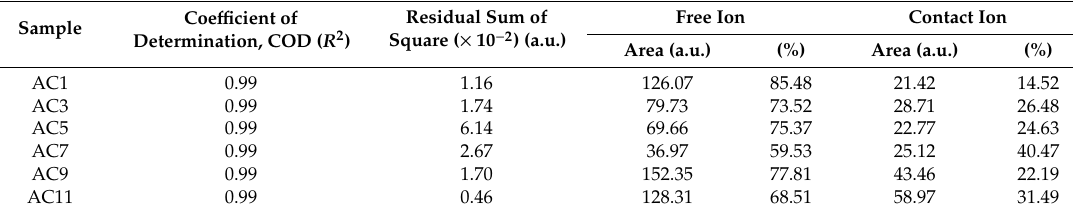
Table 4. The respective area and percentage of free ions and contact ions of each